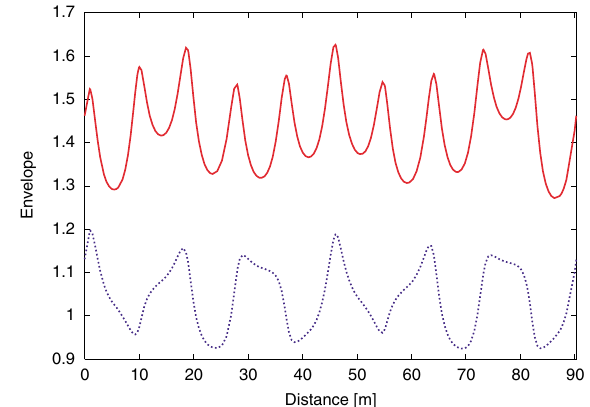
FIG. 6. (Color) Beam envelope versus distance along the PSR lattice, plotted with and without the dispersion term. The (red) solid line is the envelope plotted with the dispersion, and the (blue) dashed line is the envelope plotted without the